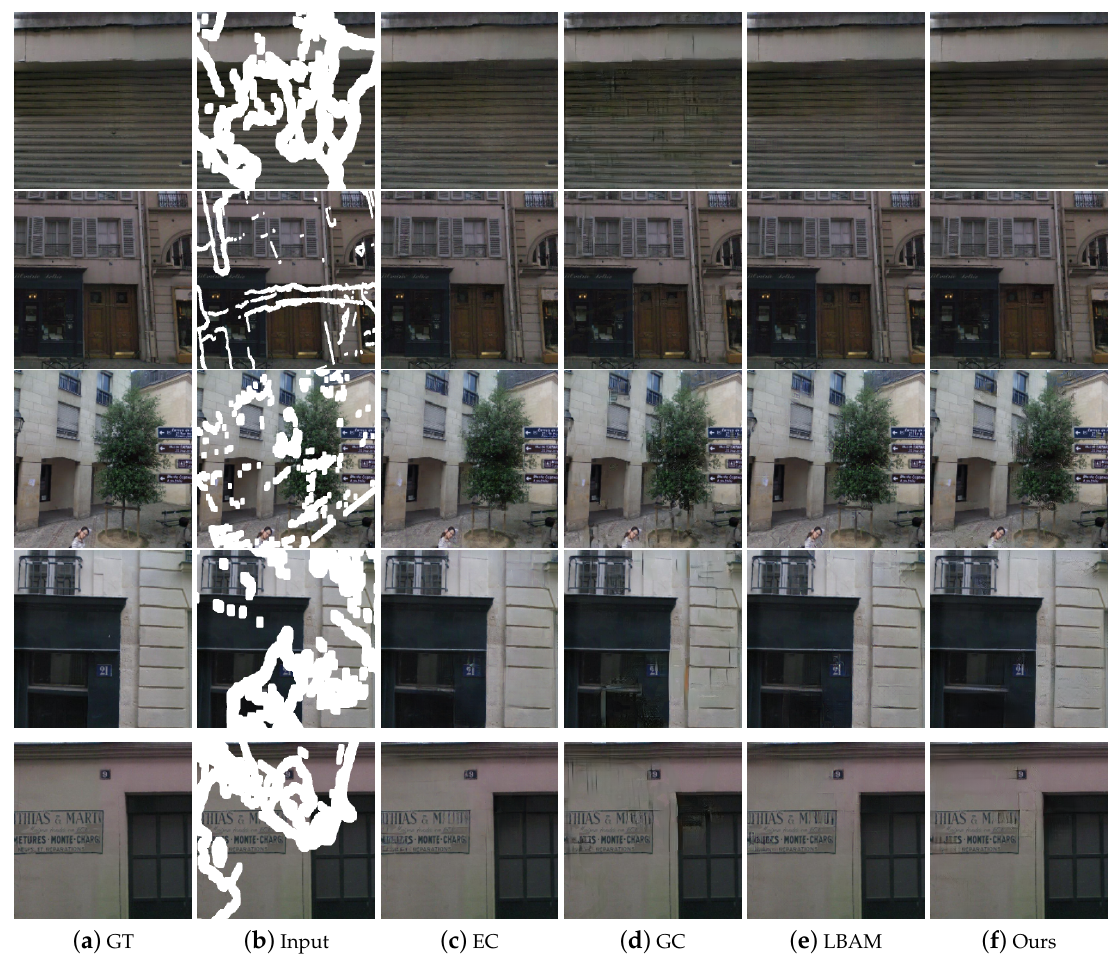
Figure 6. Qualitative comparisons of different methods on Paris StreetView [12] with irregular